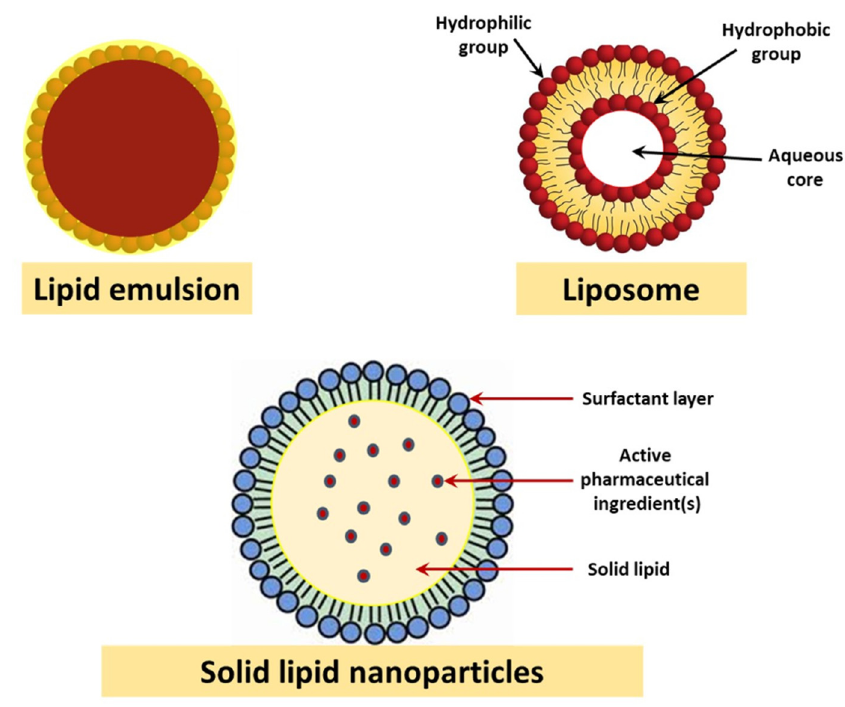
Figure 3. Different types of lipid nanoparticles used in the treatment of AD.